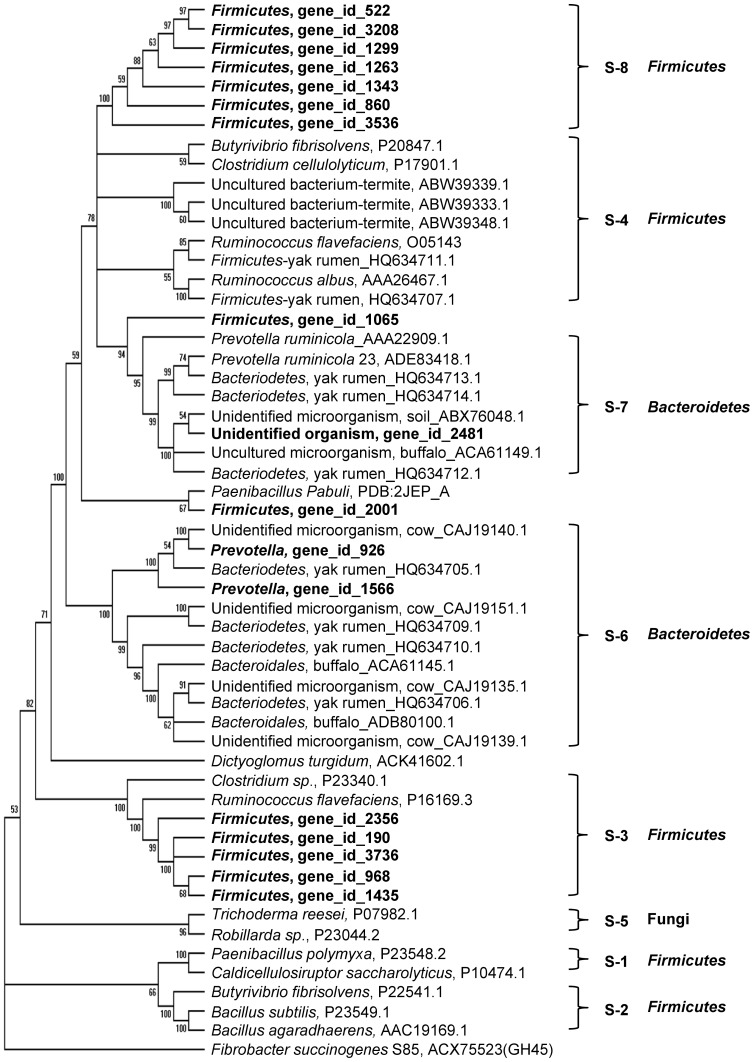
A phylogenetic tree of the putative GH5 proteins from the available metagenomic datasets.The tree was drawn using the Neighbor-Joining method with bootstrap replication of 500. Branches with ≤ 50% bootstrap support were collapsed. The evolutionary distances were calculated using the p-distance method. Names of proteins (or predicted proteins) were presented by the source organisms and GenBank accession number. The predicted proteins identified in this study are bolded. The GH45 protein of Fibrobacter succinogenes S85 was used as an outgroup. S-1 to S-8 are subfamilies of GH5 proteins.